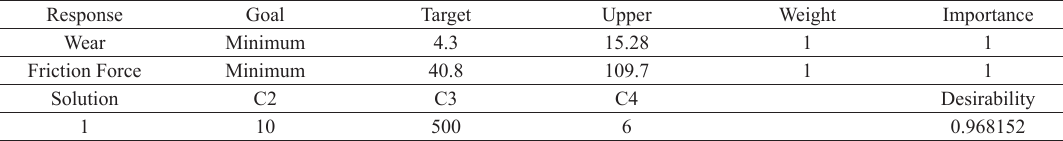
Table 5. Optimal Solution using Desirability